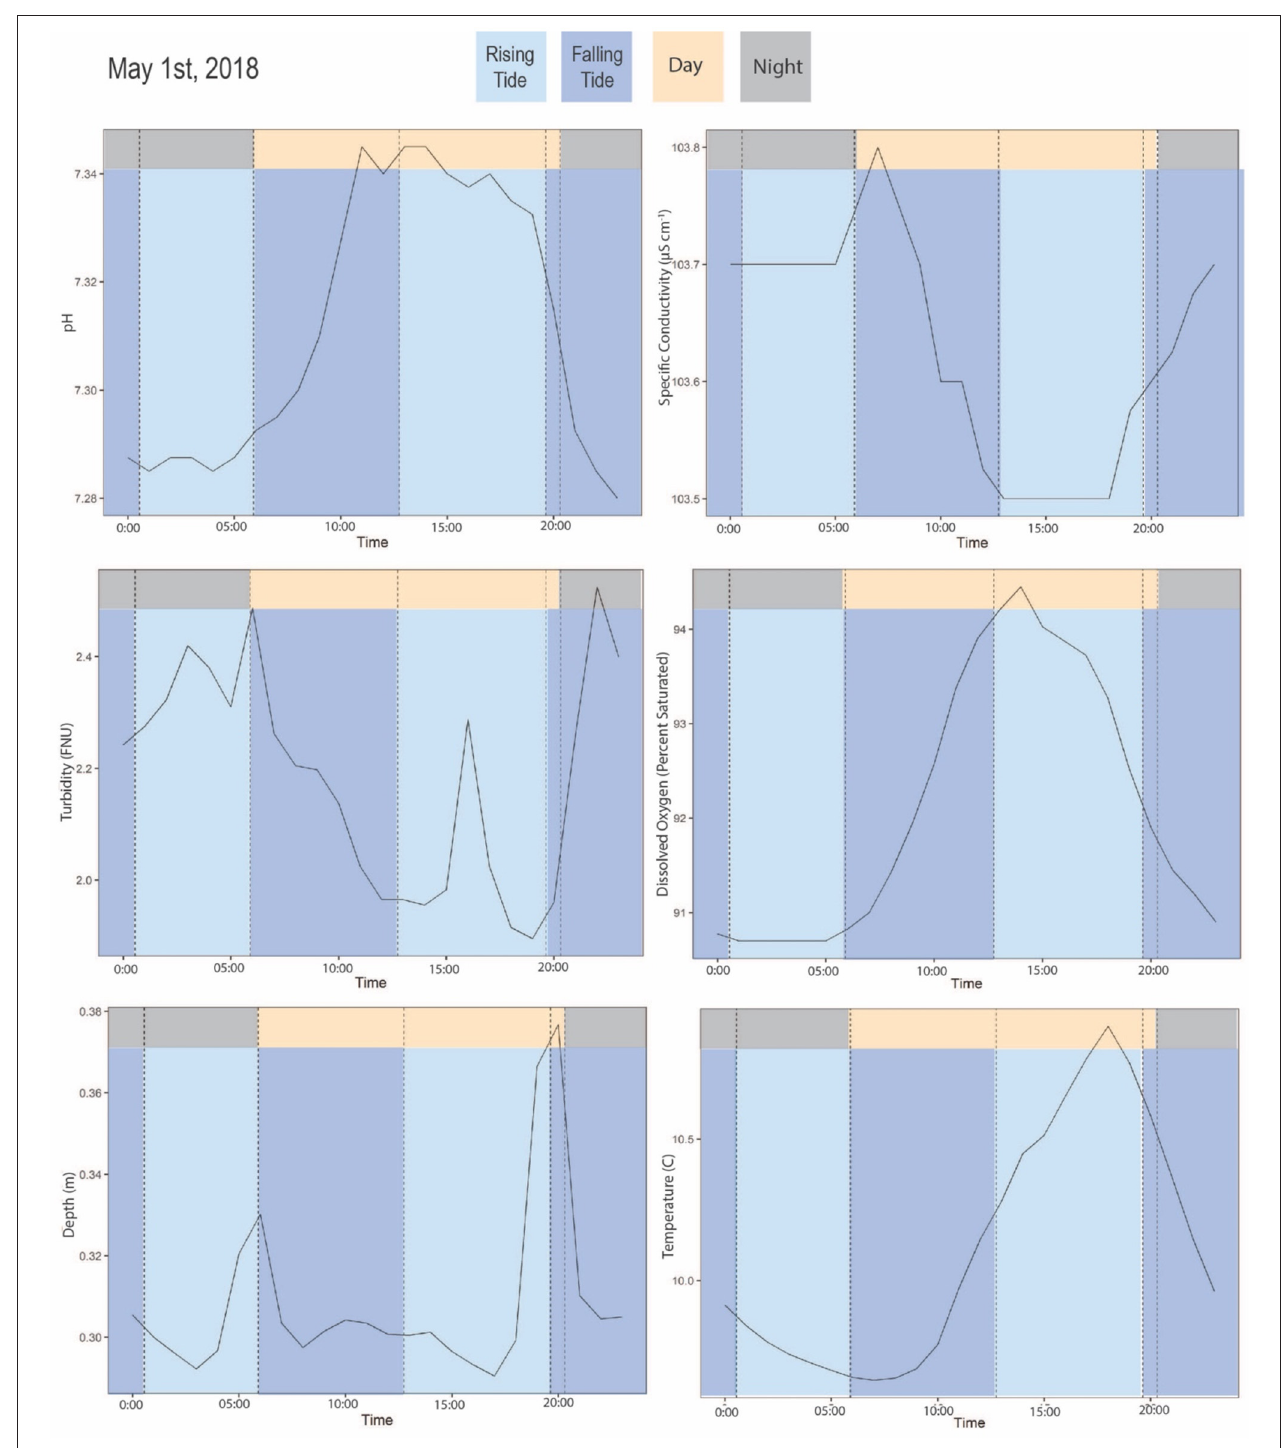
FIGURE 4 | Time series of example summer day (May 1st, 2018) averaged by hour of pH, specific conductivity, dissolved oxygen, turbidity, temperature, and depth. Colors indicate rising tide and falling tide (determined by timing of high and low tide) and day and night (determined by sunrise and sunset time).